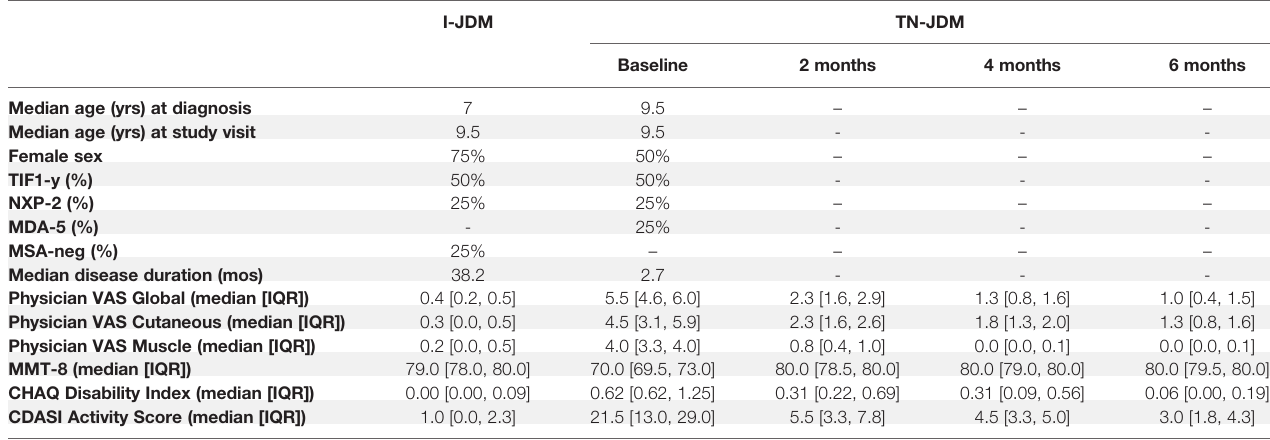
TABLE 1 | Patient